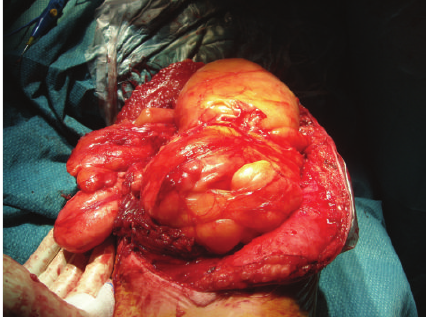
Figure 5: Tumor dissection between the rectus anterior and vastus lateralis.